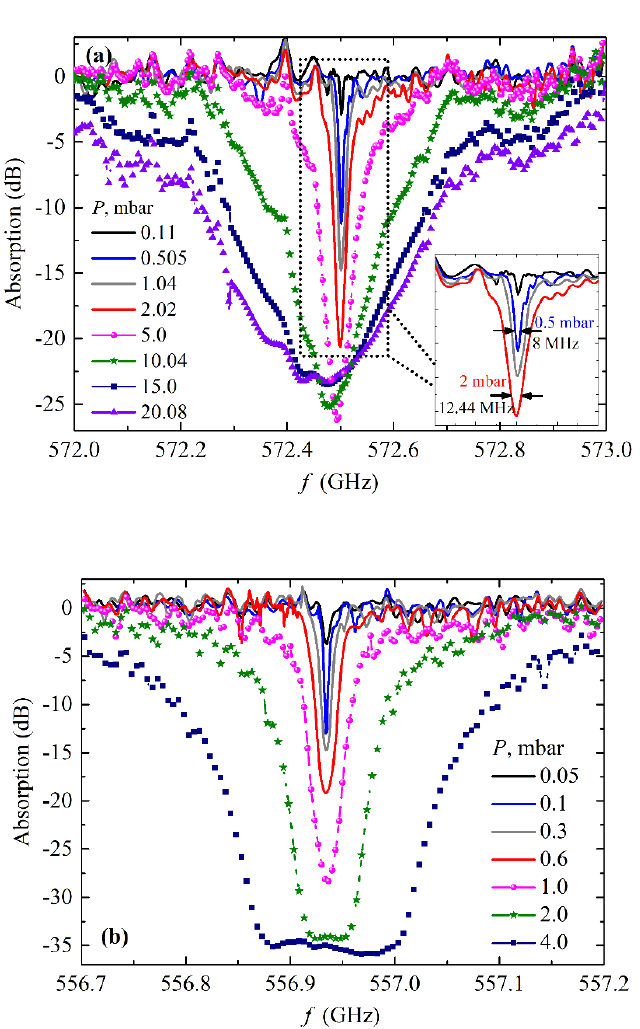
Figure 8. Absorption spectra at different pressures of ammonia, 10% water solution, ( a ) and distilled water ( b ), detected by the FFO- and the SIR-based tracing system.